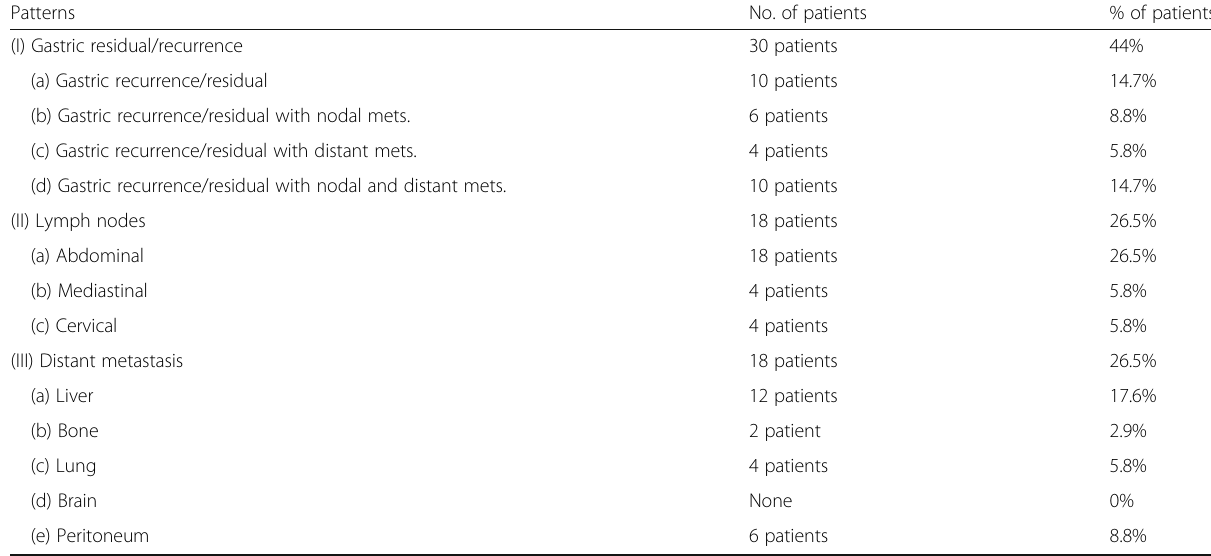
Table 5 Patterns of tumor recurrence/residual, lymph nodes (nodal), and distant metastasis (mets.) in the study by PET/CT with their number (No.) and percentage (%)